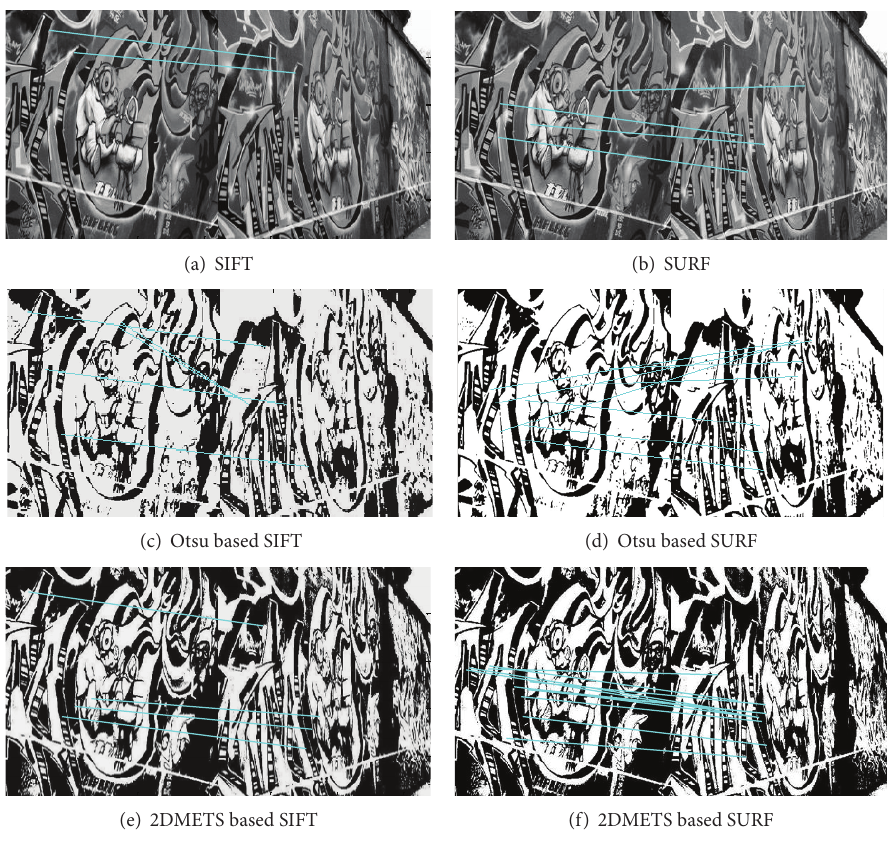
Figure 8: Target matching for images in group